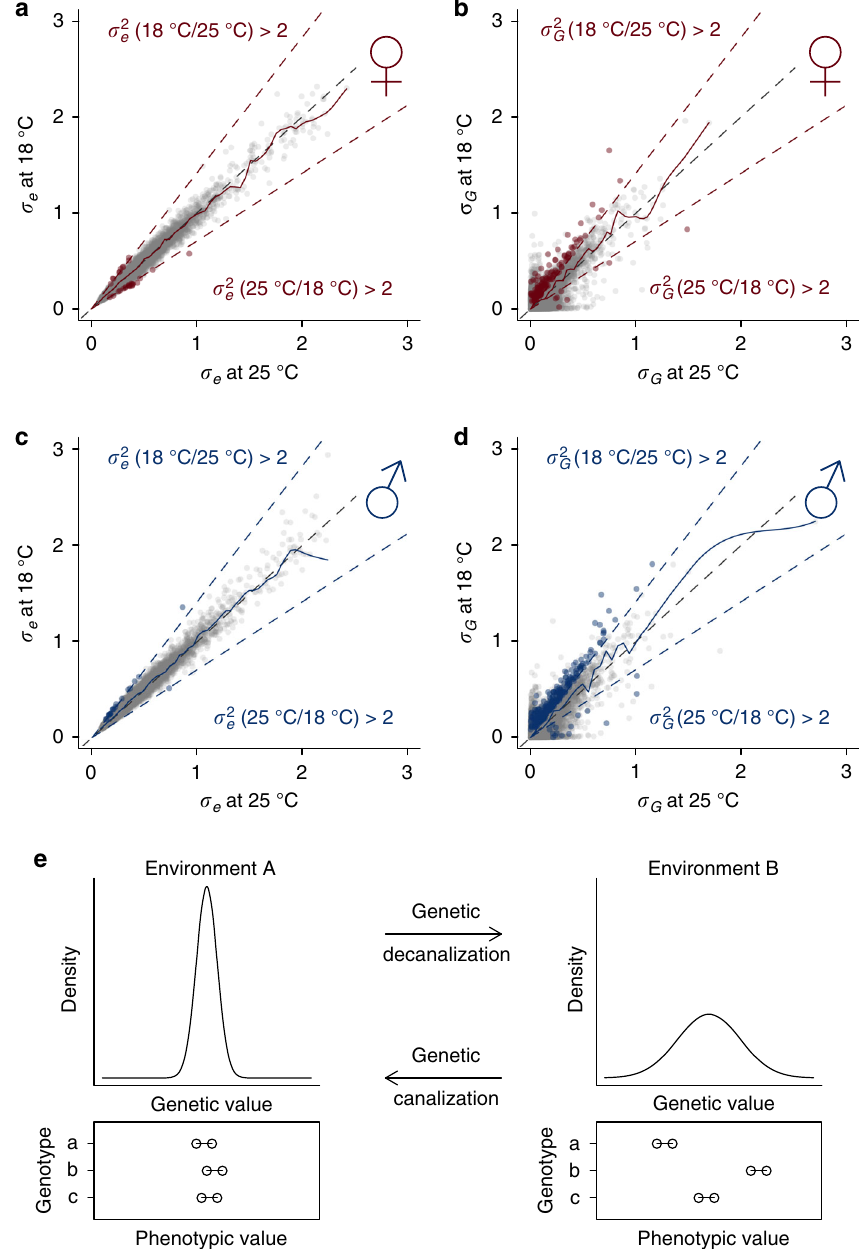
Fig. 2 Decanalization and canalization of genetic variance of gene expression at 18 °C. a Comparison of environmental variation of gene expression between 18 and 25 °C in females. The two outer dashed lines indicate twofold changes, while the diagonal line indicates no change. Note that the axes are standard deviations while the twofold change are assessed for variances. A LOESS smooth line (dark solid line) is added with a span of 0.001 at the scale of the plotted axis. Red points indicate genes with signi fi cant variance heterogeneity for σ 2 (FDR = 0.05) by at least twofold. b Comparison of genetic e variation of gene expression between 18 and 25 °C in females. The dashed lines indicate twofold changes, while the diagonal line indicates no change. A LOESS smooth line (dark solid line) is added with a span of 0.001 at the scale of the plotted axis. Red points indicate genes with signi fi cant variance heterogeneity for σ 2 (FDR = 0.05) by at least twofold and signi fi cant σ 2 (FDR = 0.05) in the environment with higher genetic variance. c , d Comparison of G G environmental and genetic variances in males, where blue points indicate genes with signi fi cant variance heterogeneity. e Plots illustrating the dynamics of genetic variances (genetic decanalization/canalization) between two environments. The density plots show the distributions of genetic values for individuals in the same population in two environments (A and B). Below the density plots are line graphs showing phenotypic values where points connected by lines are biological replicates from the same genotypes to illustrate microenvironmental